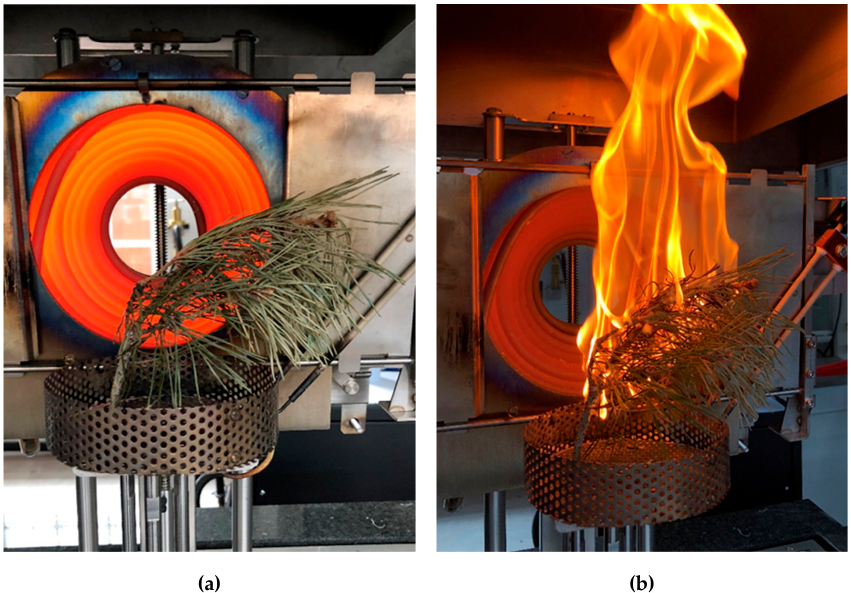
Figure 1. Example of testing branch-level flammability. A section of a branch (approximately 10